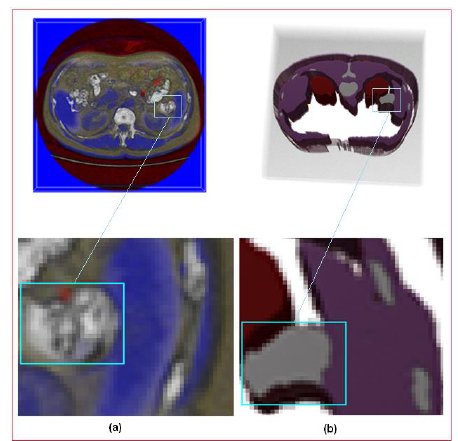
Figure 27. Bone and liver at 600% magnification (a) Ray Casting (b) This